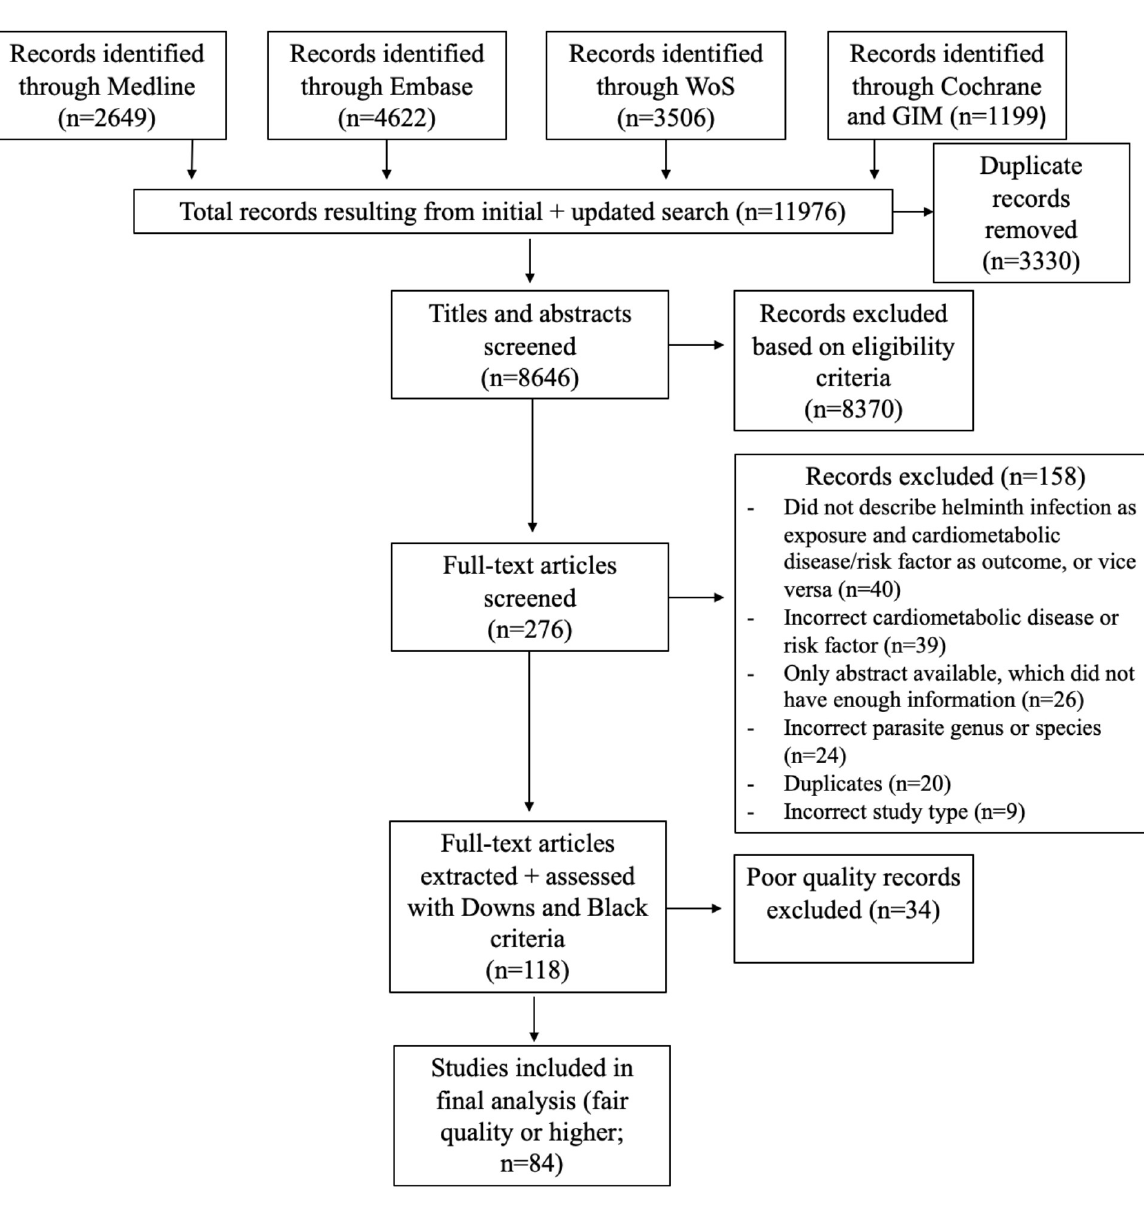
Fig 1. PRISMA flow diagram of systematic